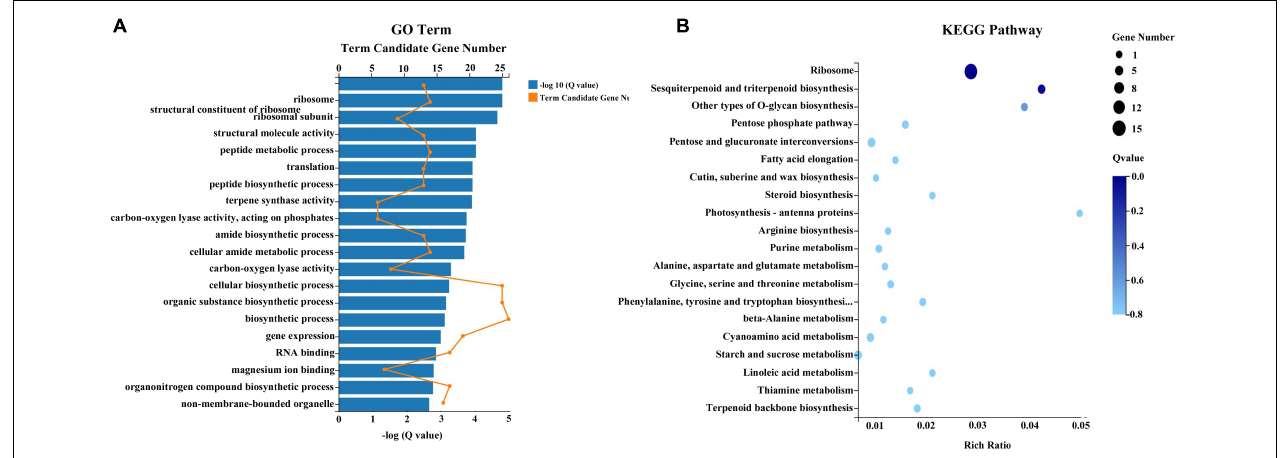
FIGURE 10 | GO (A) and KEGG (B) pathway enrichment analyses of the 117